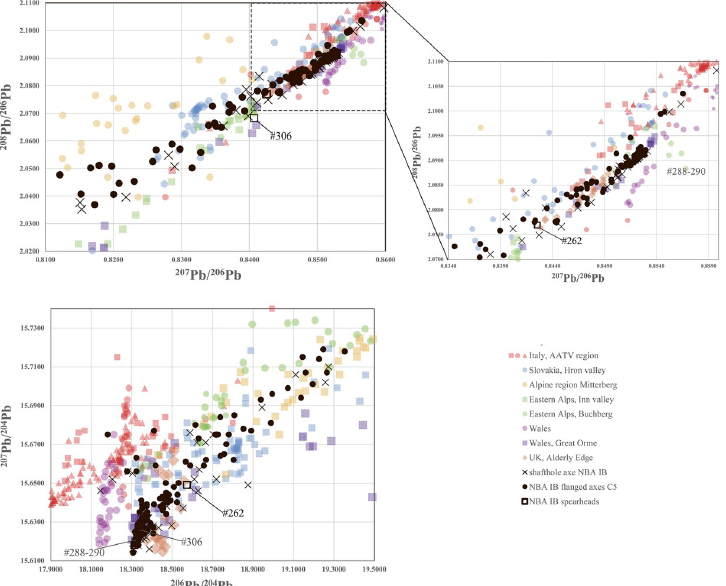
Fig 14. Lead isotope ratios of artefacts consisting of low-impurity copper in NBA IB. The 206 Pb /204 Pb/ 207 Pb/ 204 Pb diagram (bottom) shows that the flanged axes and spearheads are in line with the identified groups of shaft-hole axes. The Vals ø magle-type spearhead #262 and the Bagterp-type spearheads #288–290 and #306 (Bagterp and Over- Vindinge) are highlighted. The ore data are from: Mitterberg ore district [35], Hron Valley, Slovakia [27,28],Inn Valley and Buchberg, Alpine region [29,30],Great Orme mining region, Wales [36–39], Alderley Edge mining region, Britain [39,83],central Wales mining region [39,84],Italy AATV mining region [32,73–75]. The analytical uncertainties are comparable with the size of the